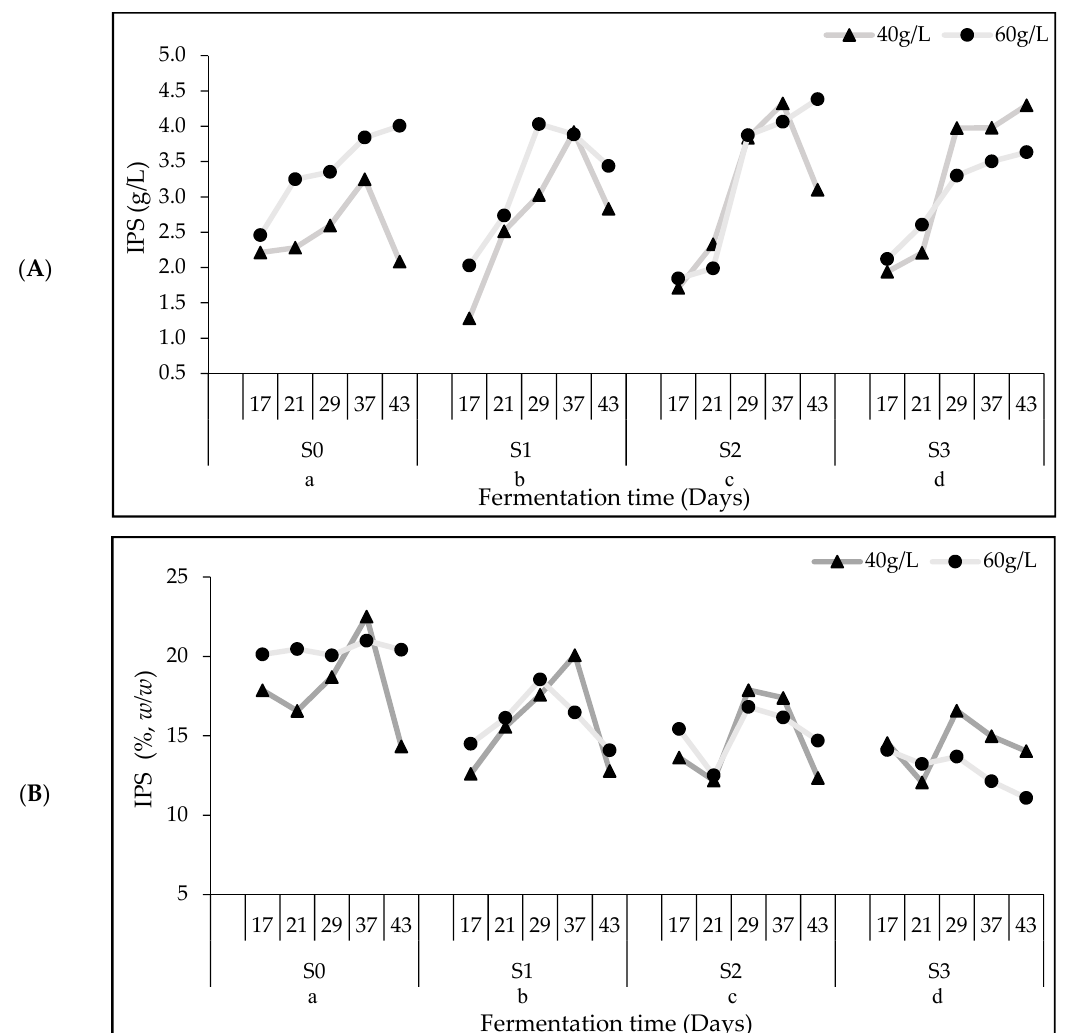
Figure 4. Production rate of intracellular polysaccharides (IPS) ( A ) in absolute (g/L) ( B ) in relative (IPS %, w/w ) values during the cultivation of P. pulmonarius in liquid cultures with OMWs containing: (a) 0 g/L phenolic compounds and initial concertation glucose 40 and 60 g/L (S0-G40, S0-G60), (b) 1 g/L phenolic compounds and initial concertation glucose 40 and 60 g/L (S1-G40, S1-G60), (c) 2 g/L phenolic compounds and initial concertation glucose 40 and 60 g/L (S2-G40, S2-G60), (d) 3 g/L phenolic compounds and initial concertation glucose 40 and 60 g/L (S3-G40, S3-G60). Each point is the mean value of at least three independent measurements, SD < 5%.